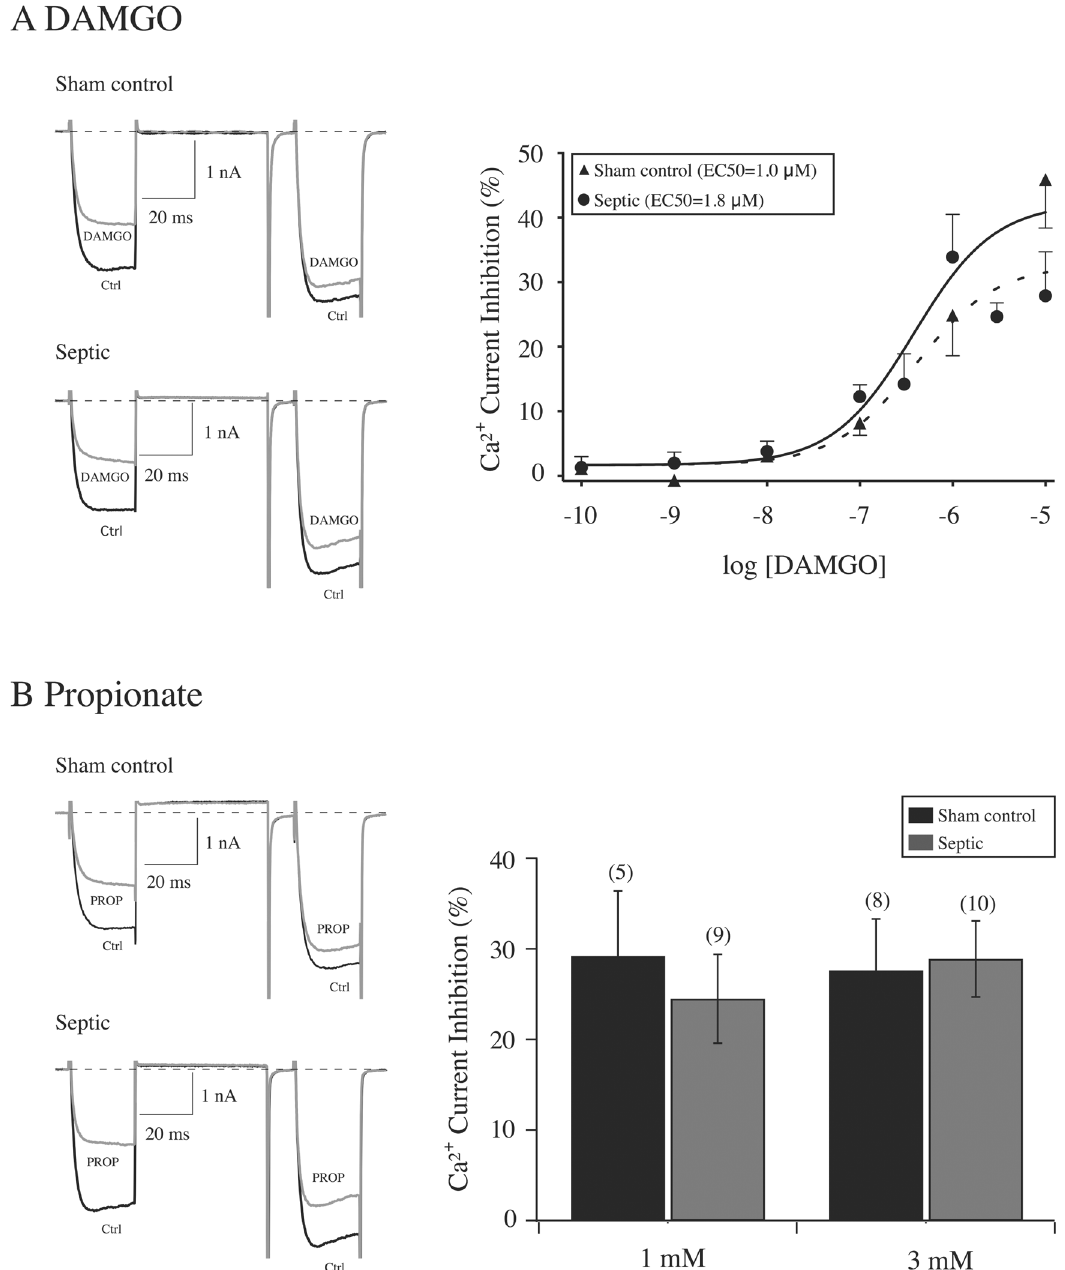
Fig 5. CSMG neurons express mu opioid (A) and free fatty acid (B) receptors. A, left, superimposed Ca 2+ current traces (evoked as described for Fig 3) in the absence (lower traces, black) and presence (upper traces, gray) of 10 μ M DAMGO for sham control and septic rats. A, right, DAMGO concentration- response relationship of CSMG neurons from sham control ( ▲ ) and septic ( ● ) rats. Each data point represents the mean ( ± SE) DAMGO-mediated prepulse current inhibition from 3 to 9 neurons, (except for 0.1 nM DAMGO for sham group where n = 2). Both smooth curves were obtained by fitting the points with the Hill equation and the fits were not significantly different (P > 0.05). The legend indicates the EC 50 values ( μ M). B, left, propionate — mediated Ca 2+ current inhibition in sham control and septic rats. B, right, summary plot indicates the mean ( ± SE) current inhibition produced by 1 and 3 mM propionate. Numbers in parenthesis indicate the number of neurons